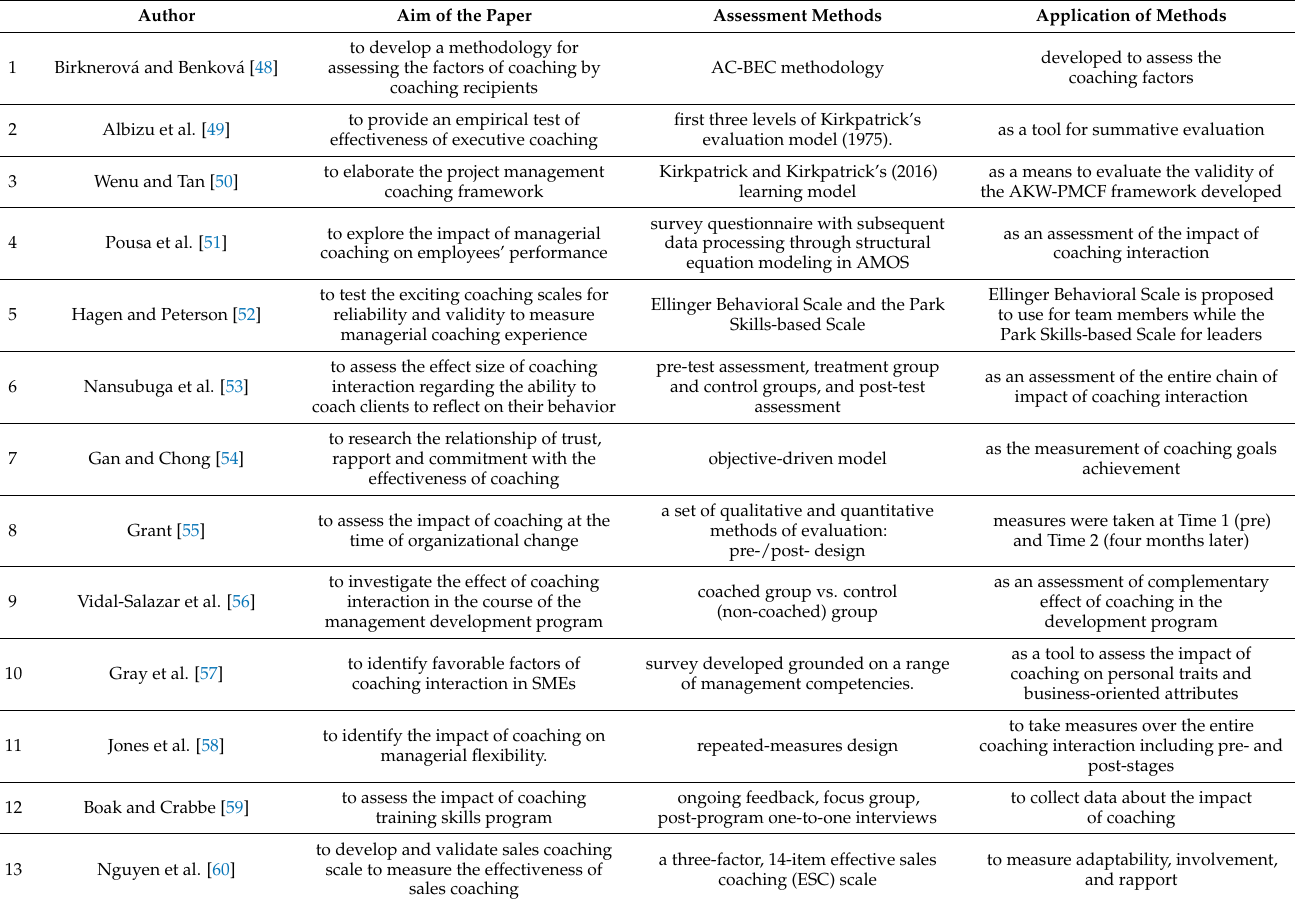
Table 2. The analysis of the papers selected for the literature